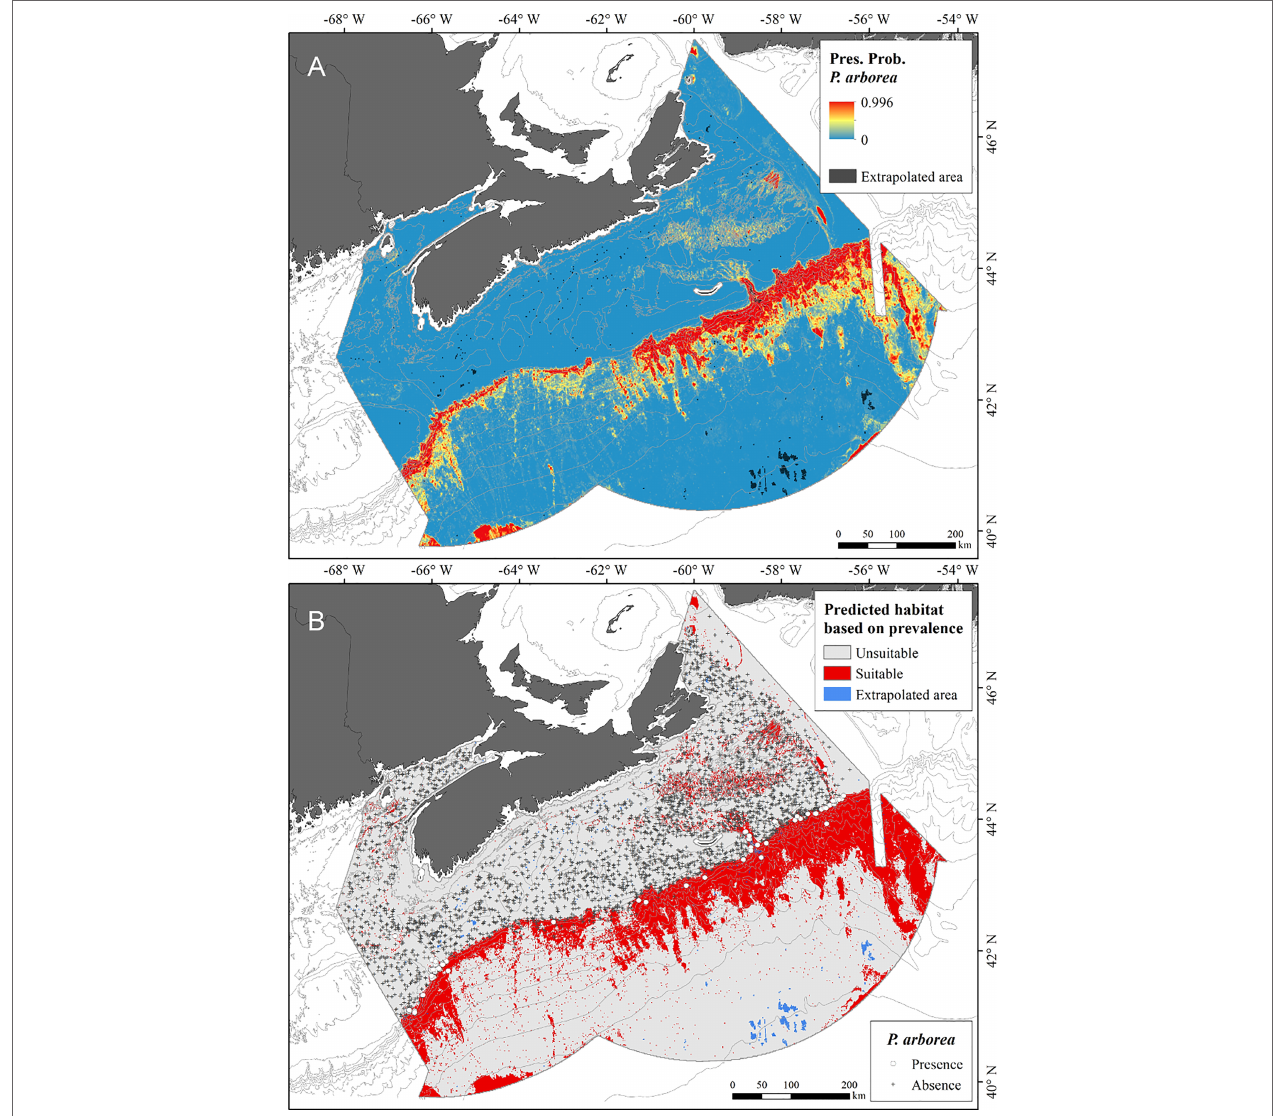
FIGURE 4 | (A) Probability of occurrence of Paragorgia arborea under present-day conditions, based on RF model constructed using 6 terrain predictors; (B) Predicted distribution of suitable and unsuitable habitat following a prevalence threshold of 0.036, overlain with locations of presence and absence response data. (Note: the combined shadings indicating extrapolated areas of predicted suitable habitat appear dark